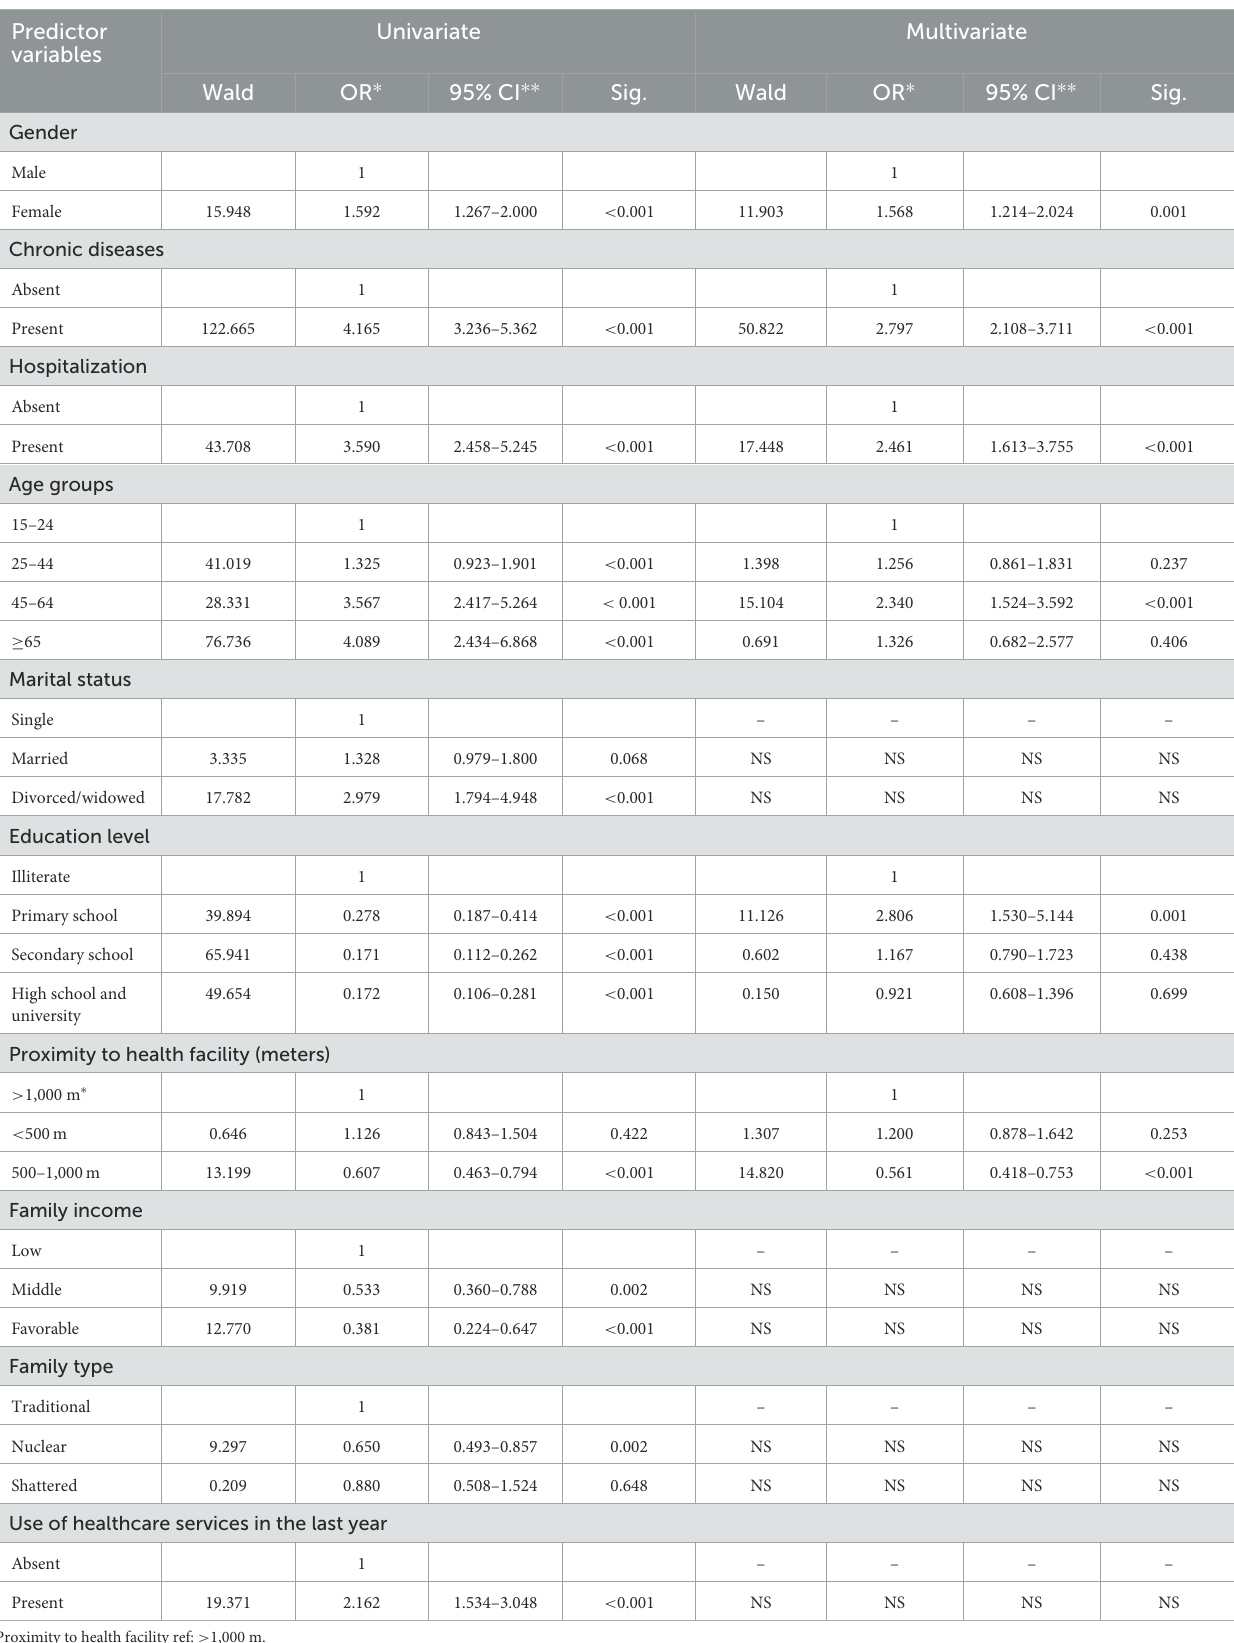
TABLE 7 Univariate and multiple logistic regression (Backward-Wald method) analyses for models predicting poor self-rated health in 2017 ( n = 1,508). Predictor Univariate Multivariate variables Wald OR ∗ 95% CI ∗∗ Sig. Wald OR ∗ 95% CI ∗∗